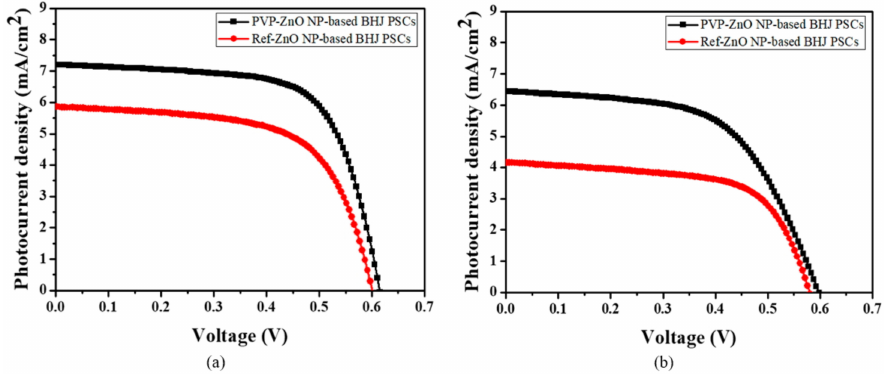
Figure 8. J–V characteristics of Ref-ZnO NP-based BHJ PSCs and PVP-ZnO NP-based BHJ PSCs at ( a ) 0 h and ( b ) 360